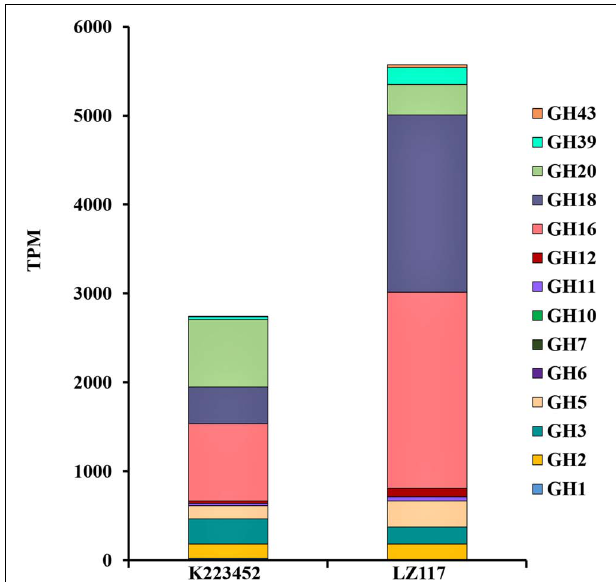
FIGURE 5 | Expression profiles of genes encoding major carbohydrate-active enzymes (CAZymes). The data were extracted from the RNA-seq analysis, which provided the expression values as TPM (Transcripts Per Million reads) mapped for each glycolic hydrolase (GH) family. CAZymes classification was performed according to the annotation of CAzymes genes in T. harzianum CBS 226.95 (https://mycocosm.jgi.doe.gov/mycocosm/annotations/browser/